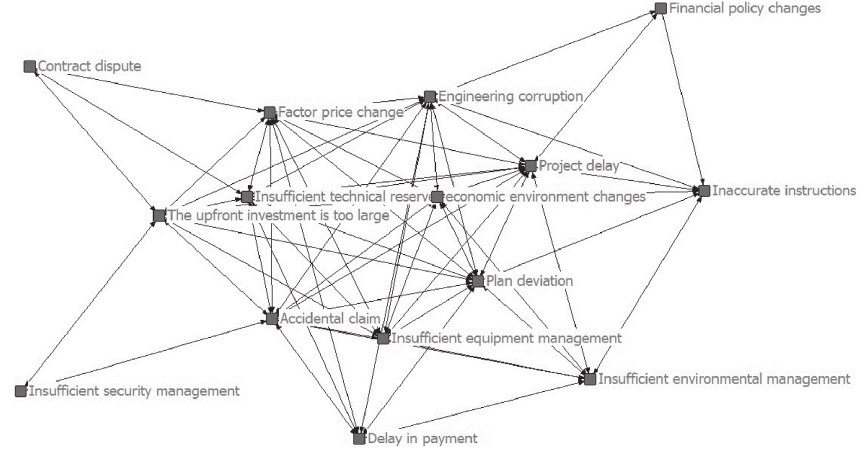
Figure 2: Risk category network.